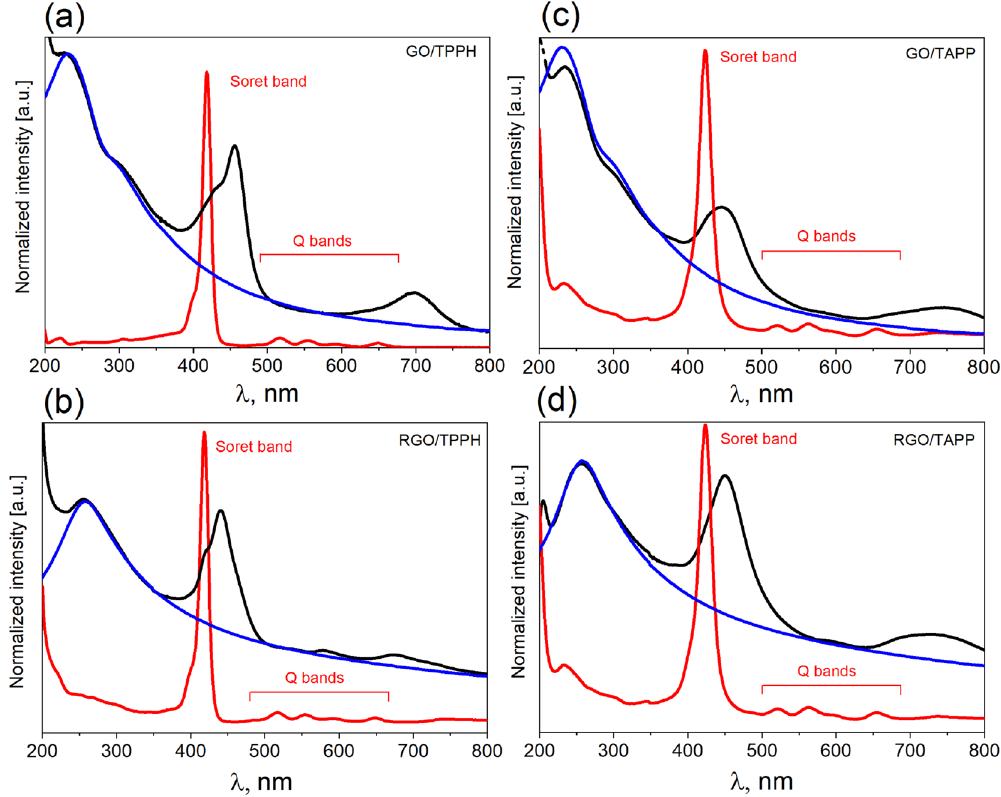
Figure 2. Experimental absorption spectra obtained for all nanohybrids studied (black lines): ( a ) GO/TPPH, ( b ) RGO/TPPH, ( c ) GO/TAPP, and ( d ) RGO/TAPP. In each case, the spectra for free TPPH and TAPP are shown in red while the spectra for free GO and RGO species are presented in blue. In the case of porphyrins, Soret and Q bands are marked.